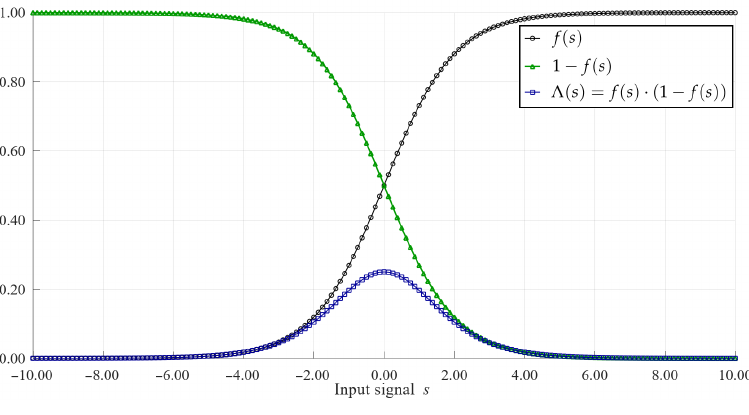
Figure 3. Functions f ( s ) , 1 − f ( s ) and their product Λ ( s ) = f ( s ) · ( 1 − f ( s